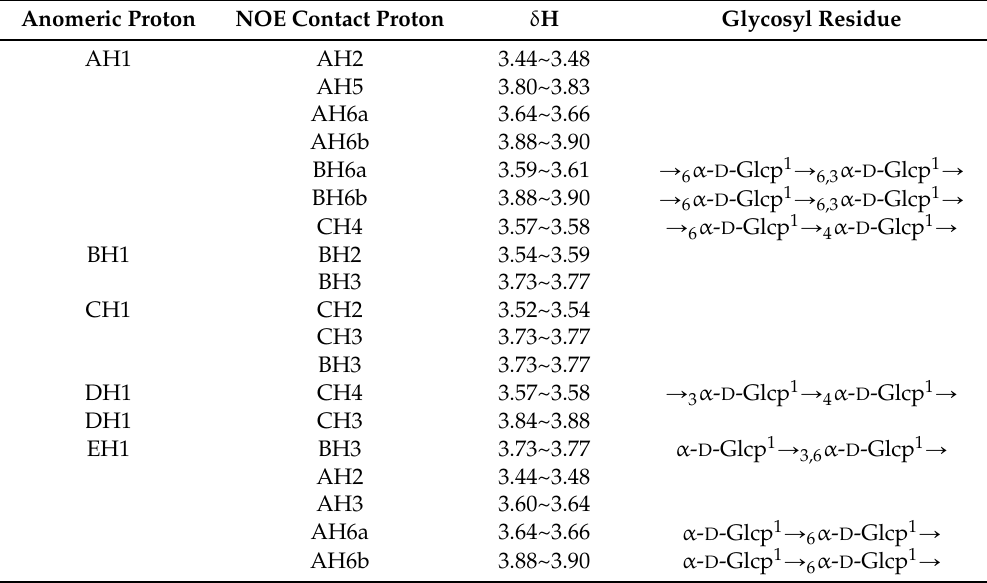
Table 4. Assignment of the NOESY spectra of